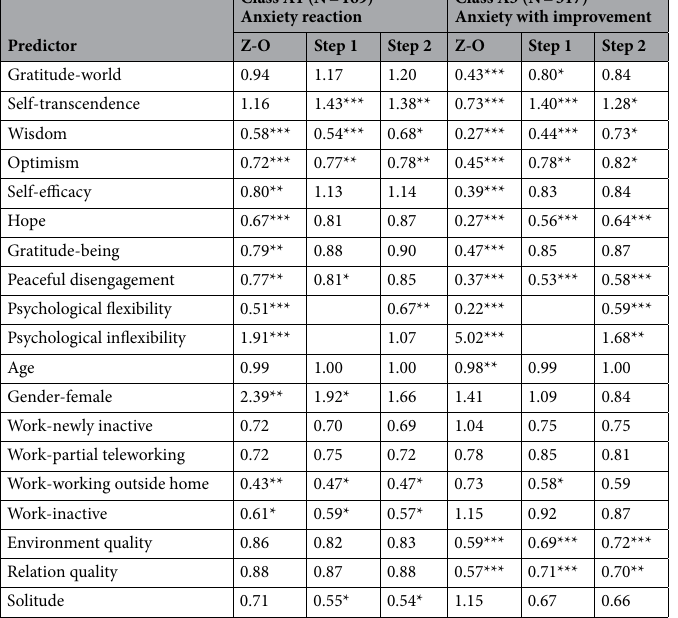
Table 6. Odds ratio of being in the anxiety symptomatology classes (Classes A1 and A3) versus being in the no anxiety symptomatology class (A2) depending on psychological resources (Step 1) and psychological flexibility (Step 2), controlling for sociodemographic variables. Values in Step 1 and 2 columns are the odds ratio from the logistic regression models predicting membership of the anxiety classes with no